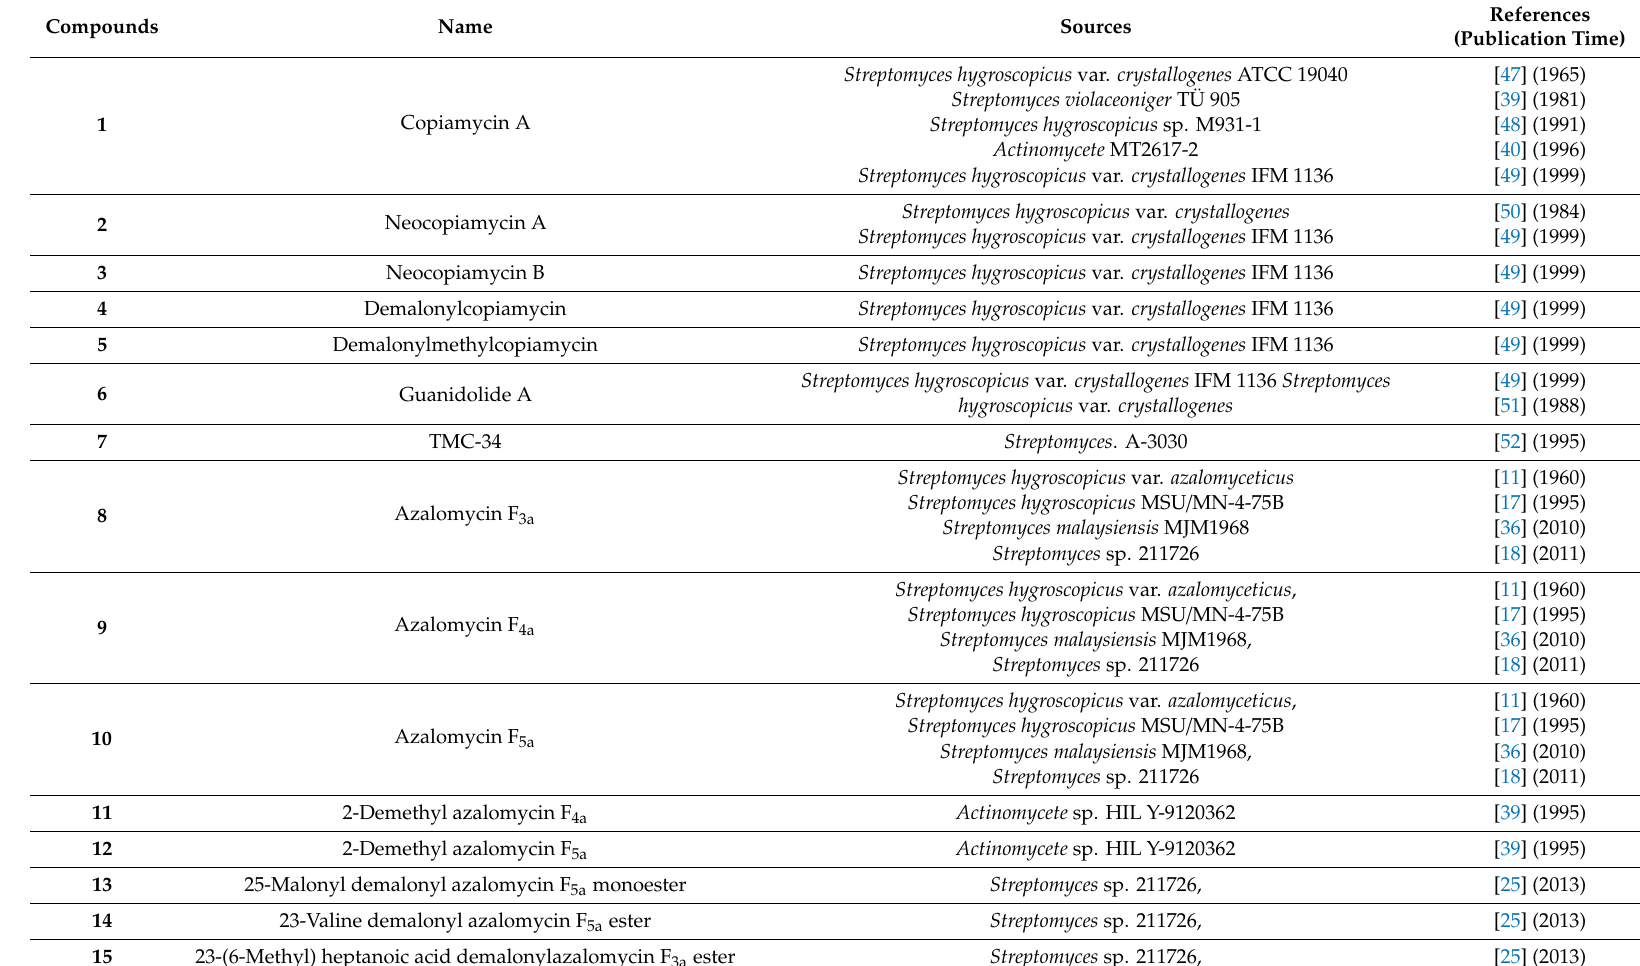
Table 1. Guanidine-containing polyhydroxyl macrolides from a natural